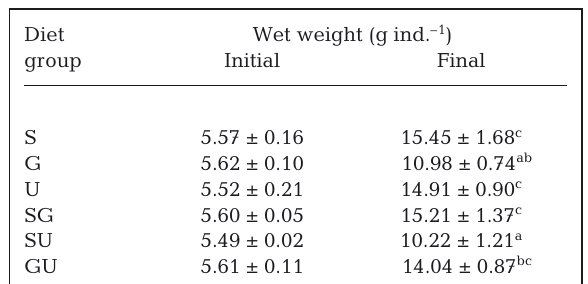
Table 2. Initial and final body wet weight of Apostichopus japonicus in different diet groups. Data are mean ± SD (n = 3). Different letters in same row represent significant differences between diets at the significance level of 0.05 (p < 0.05). See Fig. 1 legend for descriptions of diets